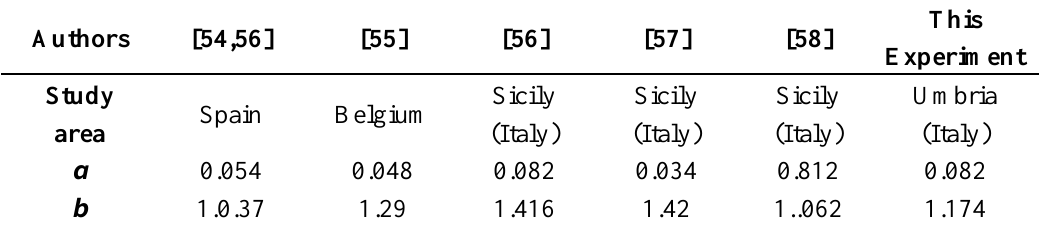
Figure 14. Analysis of the influence of BW/TW on the estimation of the volumes. A sketch of cross sections with different values of BW/TW is shown in the inset, different colors of the lines correspond to different value of the BW/TW . The thin lines represent the fit for the 50th percentile of the V-L relationship that was obtained for different BW/TW values, and the thick lines are the fits that were obtained for BW/TW = 0.6. The shaded areas represent the uncertainty of the volume estimates of the power law fits that is related to the error in the depth evaluation (Figure 12). The dots represent the volumes and lengths of the rills and ephemeral gullies that were measured in the field. Table 6. Values of the coefficients a and b from the interpolation of the data that were collected from satellite stereo-pairs and the coefficients for ephemeral gullies that were obtained by several